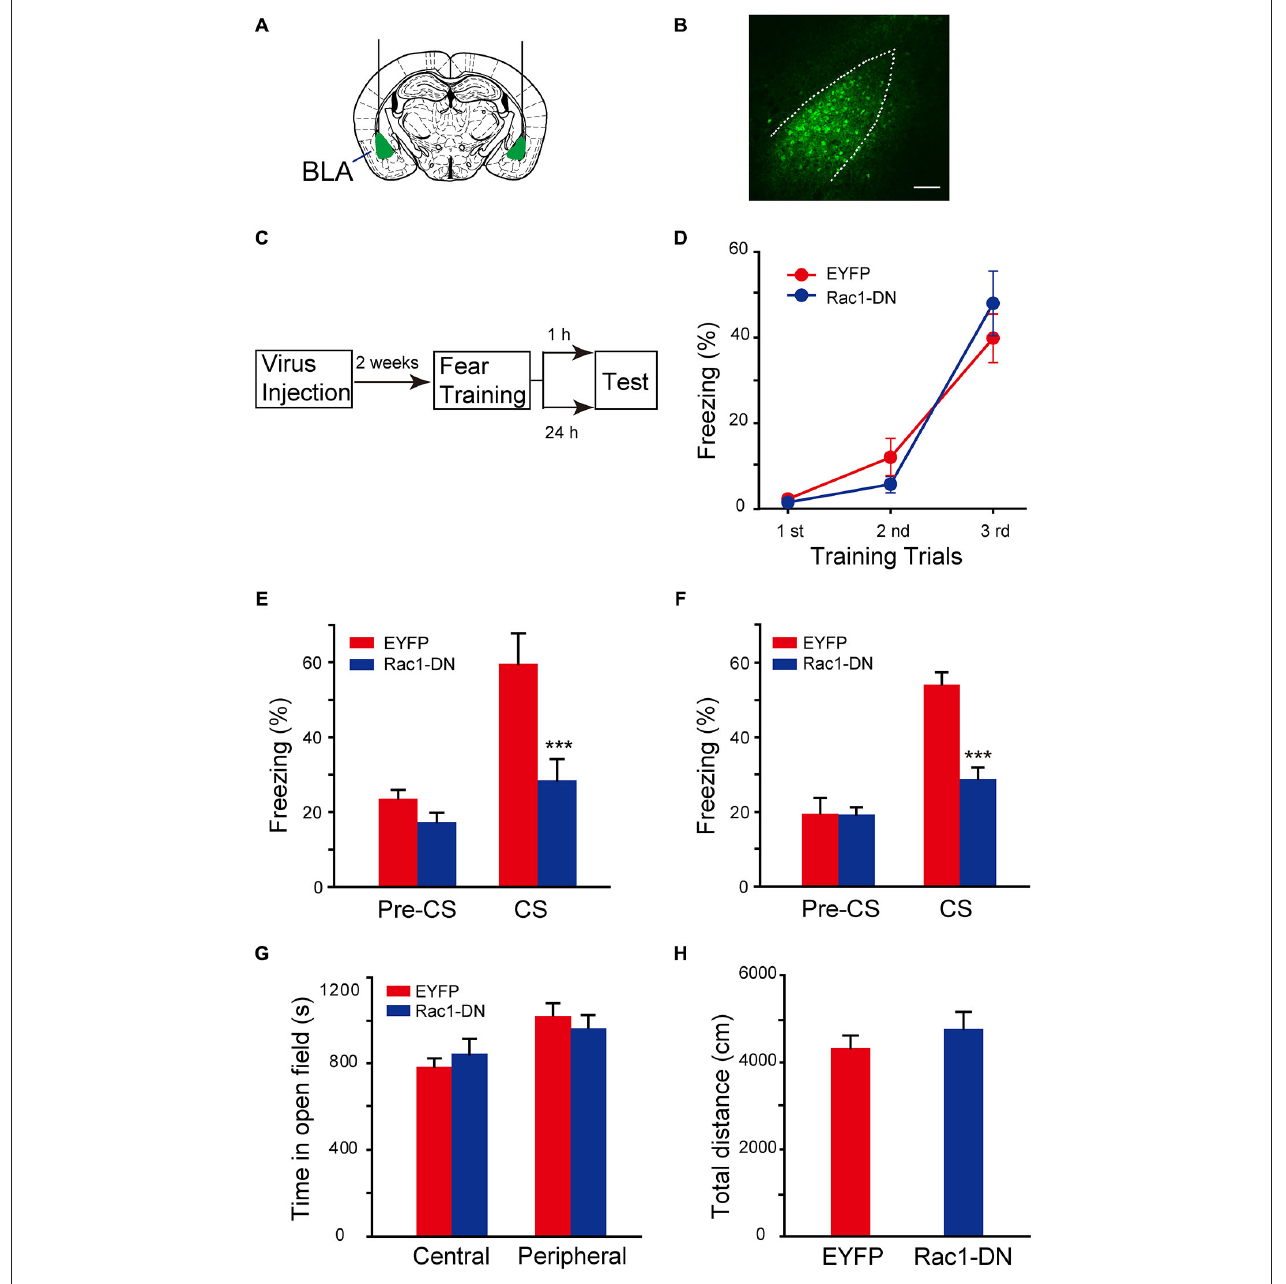
FIGURE 3 | Expression of Rac1 dominate-negative mutants in BLA blocked both STM and LTM of conditioned fear . (A) Schematic representation of AAV injection sites. (B) Fluorenscence image of AAV infection in BLA. Scale bar: 100 µ m. (C) Experimental design. Two weeks after AAV injection, mice were subjected to fear conditioning training followed by 1 h or 24 h memory test. (D) The freezing levels during each tone in training session (EGFP: n = 15, Rac1-DN: n = 14). (E,F) The expression of Rac1 DN mutant in BLA decreased the freezing levels at 1 h ( E , n = 7 of each group, ∗∗∗ p < 0.001) and 24 h ( F , EGFP: n = 8, Rac1-DN: n = 7, ∗∗∗ p < 0.001) auditory fear memory tests. (G,H) The results of a 30 min locomotion test in an open-field apparatus (EGFP: n = 11, Rac1-DN: n = 10).